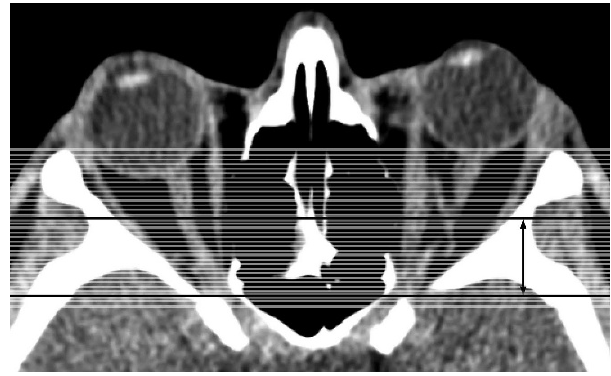
Figure 2 - Percentage difference from rest to ventilatory anaerobic threshold (rest/VAT), rest to respiratory compensation point (rest/RCP) and rest to peak of exercise (rest/Peak) in patients with coronary artery disease subjected to continuous exercise training (panel A) and interval exercise training (panel B). VAT=ventilatory anaerobic threshold; RCP=respiratory com- pensation point. * p , 0.05 vs.